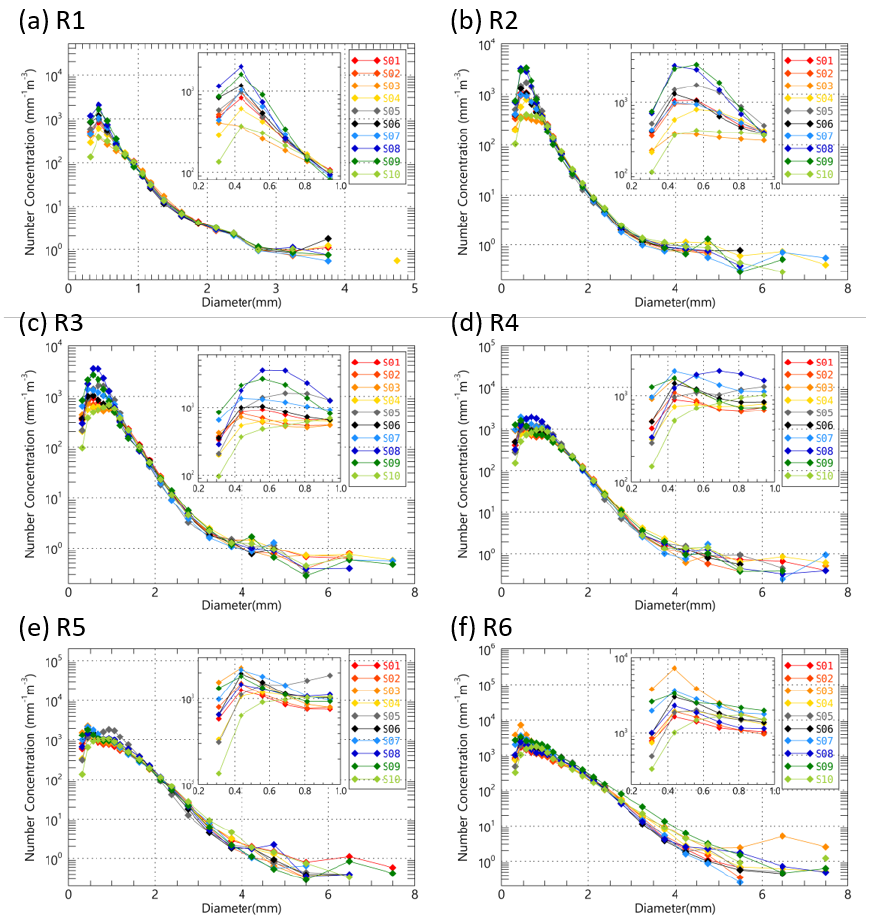
Figure 2. The average N(D) versus diameter of raindrops for rain rate categories at the 10 Parsivel sites during the entire analysis period. The inner subfigures show the average N(D) versus diameter from 0.2 mm to 1.0 mm.